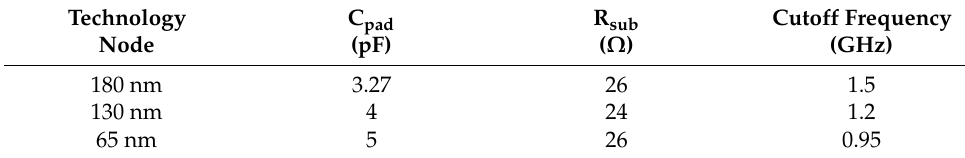
Figure 5. Voltage transfer versus frequency. Table 1. Cutoff frequencies of 180 nm, 130 nm, and 65 nm technology node.